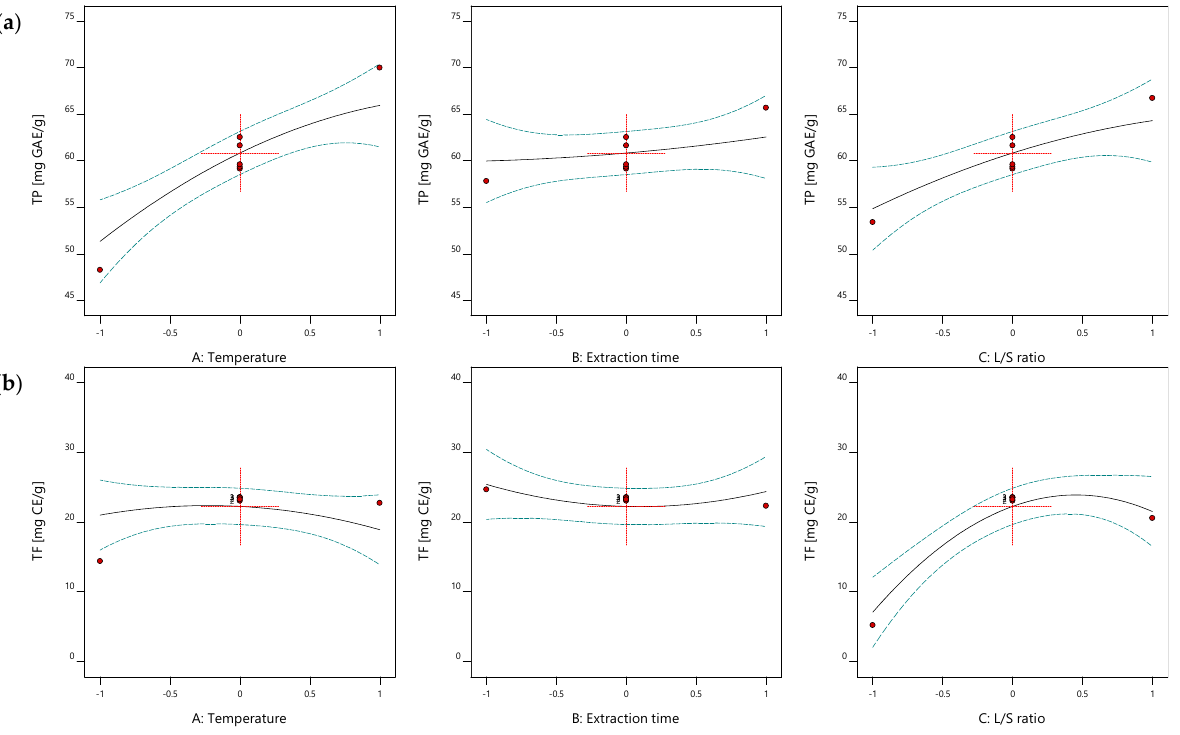
Figure 4. The effect of NADES extraction parameters (temperature, extraction time and L/S ratio) on ( a ) TP and ( b ) TF.